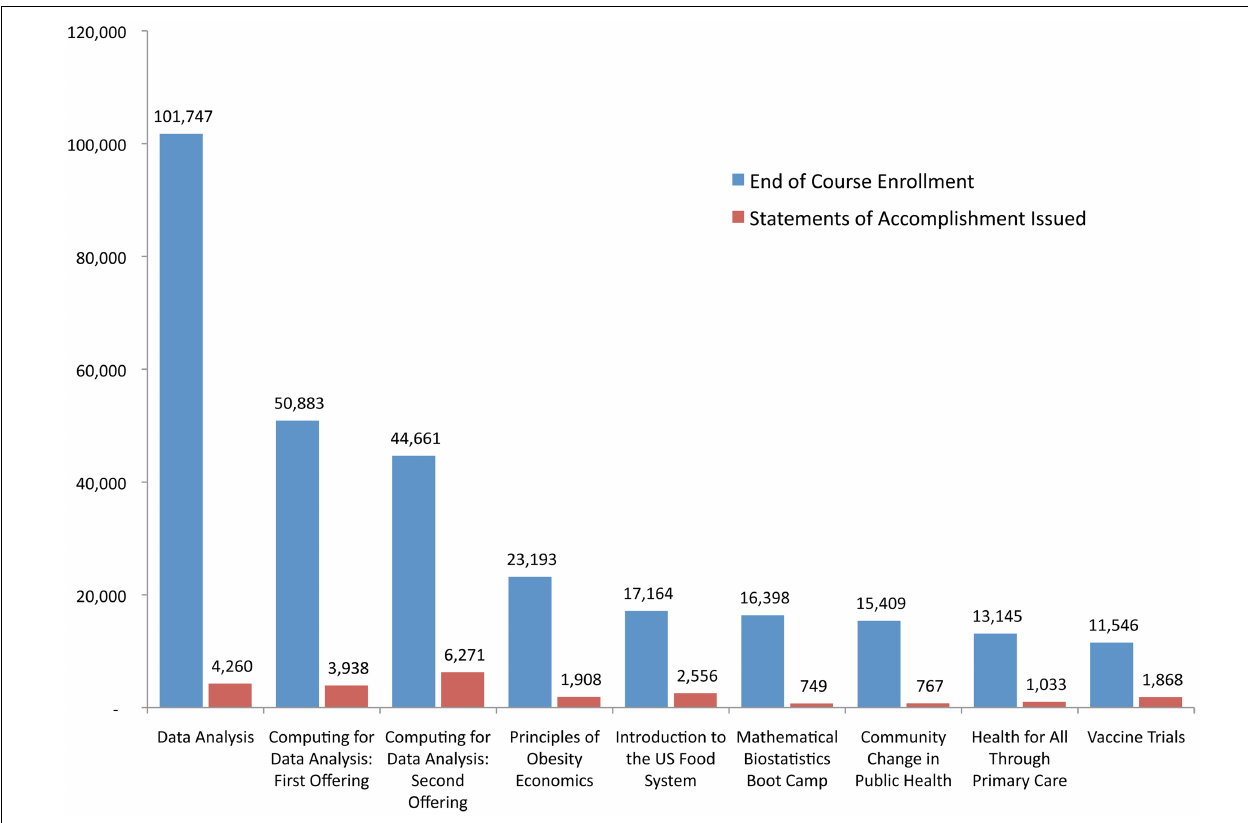
FIGURE 1 | End of course enrollment and statements of accomplishment issued in nine initial JHSPH MOOC offerings .